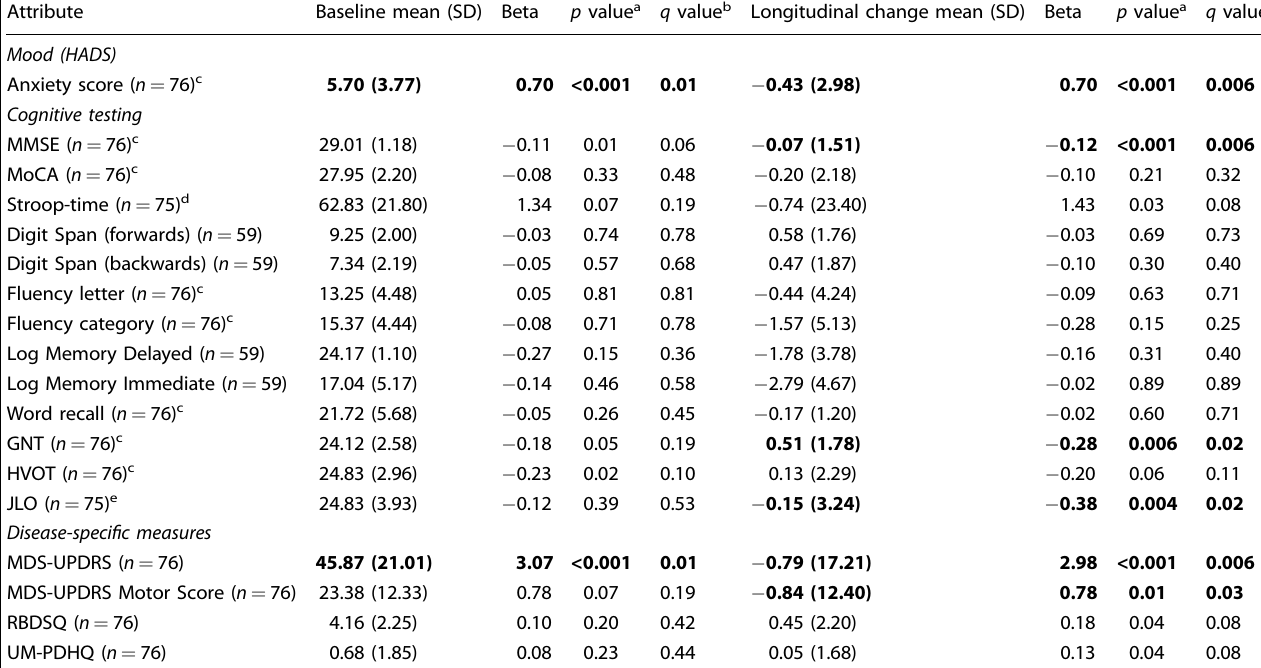
Table 2. Association of HADS depression score with baseline measure and follow-up scores in anxiety, cognitive and disease-speci fi c measures.